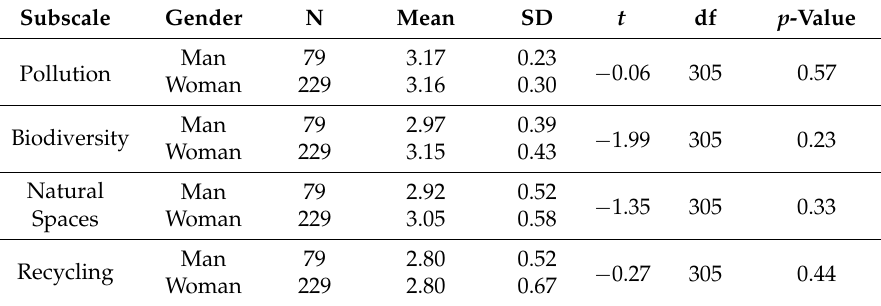
Table 3. Test t by gender in the different